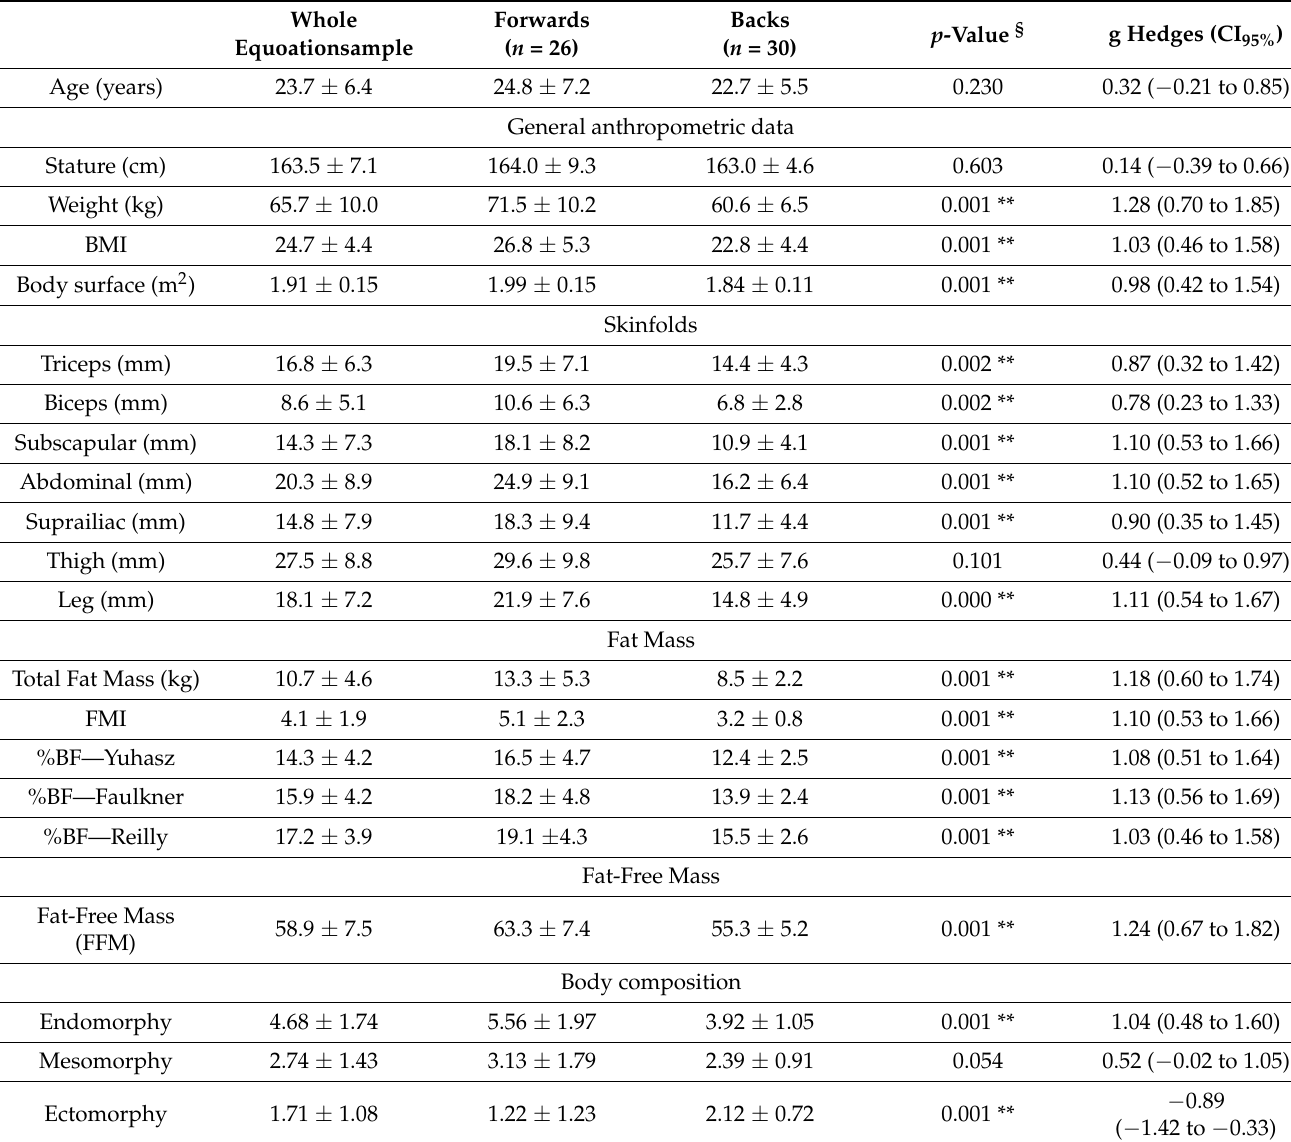
Table 2. General anthropometric data, skinfold thickness (mm), fat mass, fat-free mass parameters, and body composition profile of the female rugby players included in the study. Differences according to player position are also